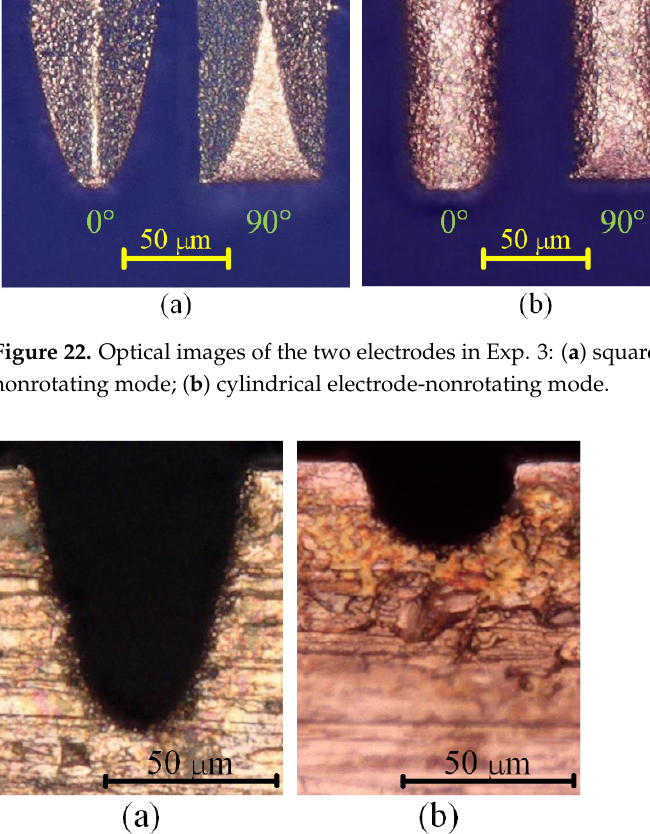
Figure 23. Optical images of the two entrance profiles of the microgrooves in Exp. 3: ( a ) square electrode-rotate 45 ◦ in advance-nonrotating mode; ( b ) cylindrical electrode-nonrotating mode.